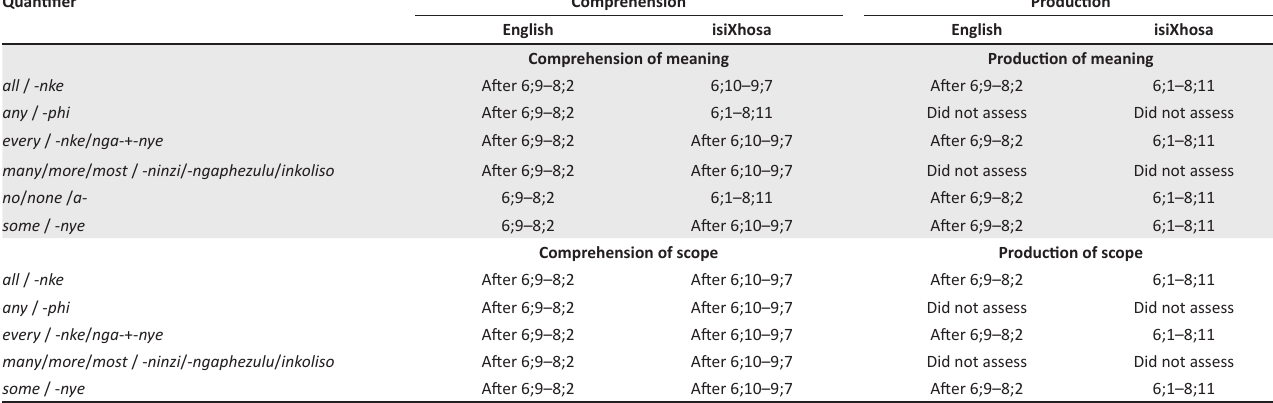
TABLE 4: Age of acquisition of comprehension and production of quantifiers based on data from the current study Quantifier